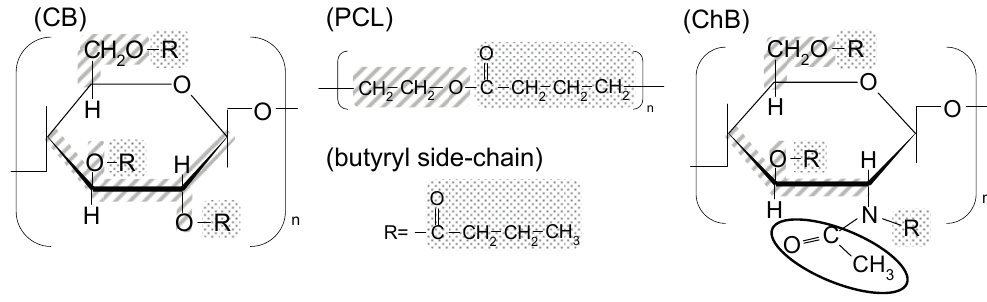
Figure 14. Schematic representation showing the structural similarity between the PCL repeating unit and the cellulose (CB) and chitin butyrate (ChB) butyryl side groups. Reproduced with permission from ref. [45]. Copyright 2009 Elsevier